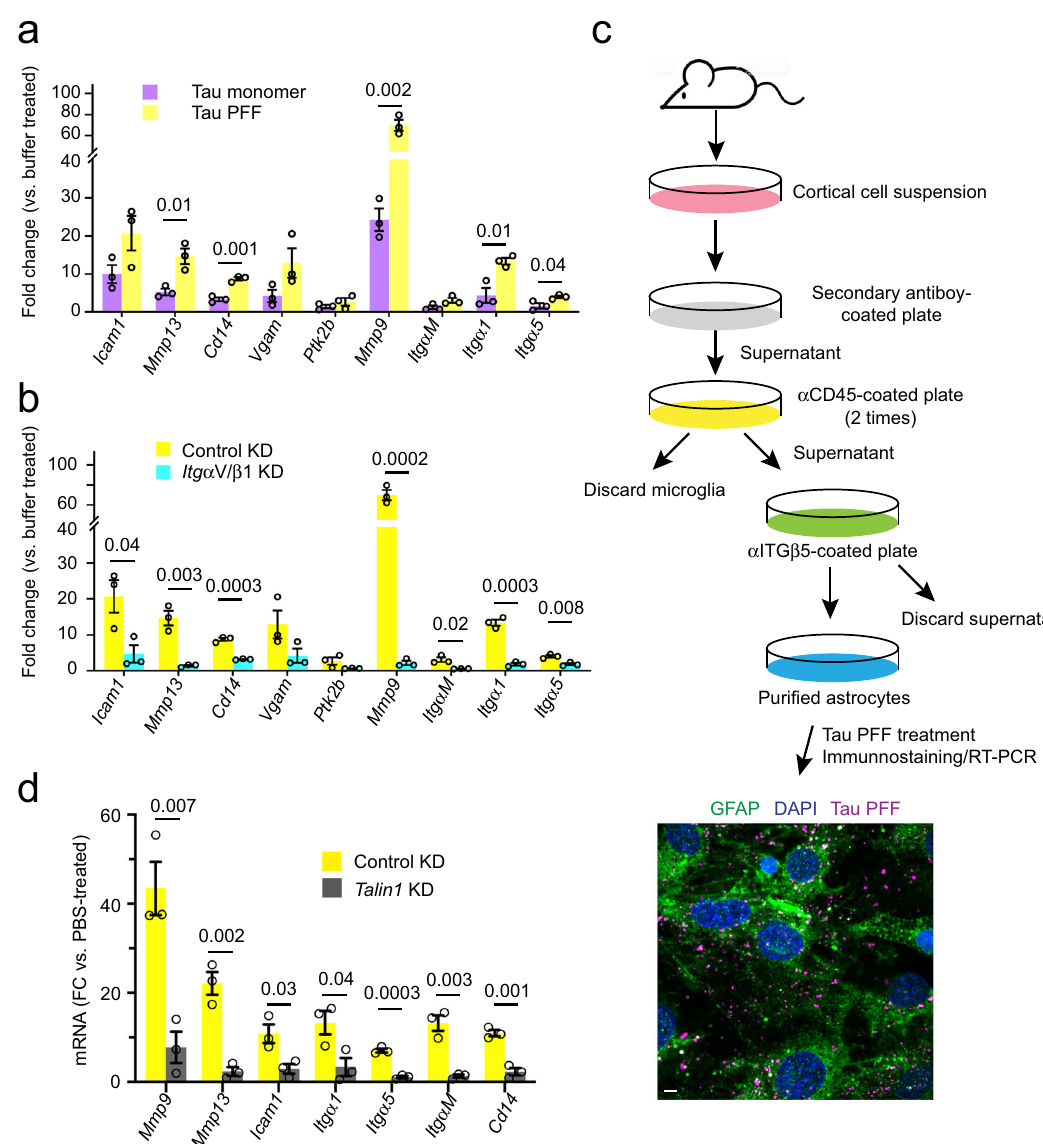
Fig. 3 Monomeric and fi lamentous Tau differentially activate integrin signaling. a , b Tau PFF activates integrin signaling in an ITG α V/ β 1 dependent manner. qRT-PCR analyses of the expression of a collection of integrin target genes in primary astrocytes. Cells were fi rst infected with either control or ITG α V/ β 1 shRNA for 72 h and then treated with PBS, monomeric Tau, or Tau PFFs (200 nM) for 6 h. Shown are fold changes (FC) normalized to PBS-treated samples. a A comparison between Tau monomer and PFF. b A comparison of Tau PFF treatment in control vs. ITG α V/ β 1 knockdown cells. Mean ± SEM, n = 3 independent experiments, each with two technical repeats. c A schematic overview of the immuno-panning strategy for puri fi cation of astrocytes using anti-ITG β 5 antibodies. Brie fl y, cortical cell suspensions were passed successively over secondary antibody-coated and anti-CD45-coated plates to remove macrophages and microglia, and then plated in a positive selection panning plate for astrocytes (anti-ITG β 5 coated). The lower panel shows a representative immuno fl uorescence image of puri fi ed astrocytes treated with Tau PFF Alexa594 (200 nM) (Magenta) 1 h and then stained with anti-GFAP antibodies (Green) and Hoechst (Blue). Scale bar, 5 μ m. d Talin1 is required for Tau PFF-induced integrin signaling. As in b , except that immunopuri fi ed astrocytes were fi rst infected with either control- or Talin1 shRNA-expressing lentivirus and then treated with Tau PFF. Mean ± SEM n = 3 independent experiments, each with two technical repeats. The numbers and asterisks above indicate p value (**** p < 0.0001) determined by two-tailed unpaired t induce in fl ammation, we tested whether PFF-treated astrocytes genes were not signi fi cantly affected with the exception of Cd14 , resemble the neurotoxic A1 state or the neuroprotective A2 state Tgm1 , and Ptx3 . Thus, monomeric Tau and Tau PFF appear to by determining the expression of the previously characterized convert astrocytes into an A1-like state. Knockdown of either pan-reactive, A1 and A2 signature genes. Interestingly, qRT-PCR Itg α V/ β 1 or Talin1 dramatically reduced Tau PFF-associated gene showed that both Tau monomer and PFFs induced the expression induction (Fig. 6b, c and Fig. S5), so did the treatment with PF- of many pan-reactive and A1 speci fi c genes such as Gbp2 , H2- 562271 and the NF κ B inhibitor PDTC 50 (Fig. 6d, e). Thus, Tau PFFs alter astrocytes in an integrin-dependent manner, convert- T23 , Ggta , Ligp1 , Psmb8 etc with PFFs generally causing a higher ing them to an A1-like state. level of induction than monomer (Fig. 6a). By contrast, most A2